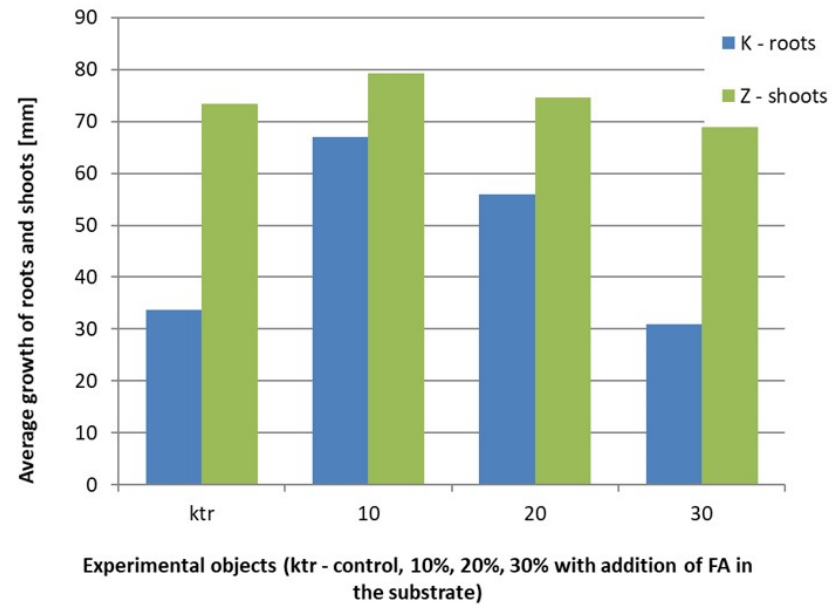
Figure 6. The growth of roots (K) and shoots (Z) of Sinapis alba on the medium with different FA ash content.